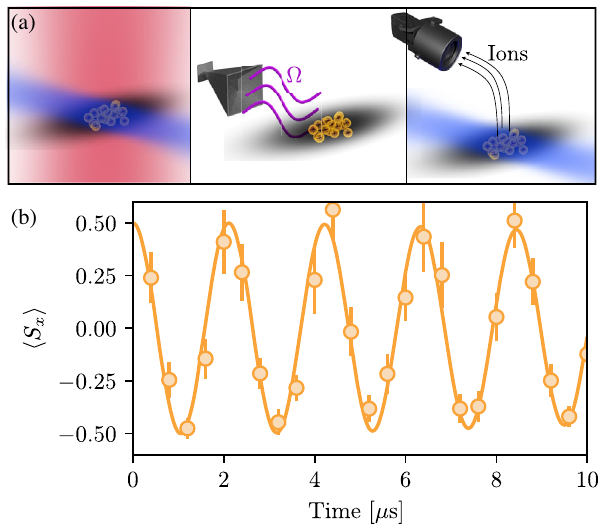
FIG. 3. Implementation of the XXZ spin- 1 = 2 model in Rydberg gases. (a) Experimental procedure. Left: A laser pulse at 780 nm (red) and 480 nm (blue) excites a controlled fraction of the 87 Rb atoms to the j ↓ i ¼ j 48 S i Rydberg state. Middle: A microwave field couples the j ↓ i state to the j ↑ i ¼ j 49 S i state to perform a Ramsey experiment. Right: A blue 480 nm laser depopulates the j ↓ i Rydberg state, before the j ↑ i state is ionized by an electric field. The ions are detected by a multichannel plate. (b) Ramsey fringes showing a high degree of phase coherence for a detuning of Δ = 2 π ¼ 0 . 47 MHz for a peak spin density of ρ 0 ¼ 6 . 0 ð 15 Þ × 10 7 cm − 3 . The solid line S shows discrete truncated Wigner approximation simulations for that